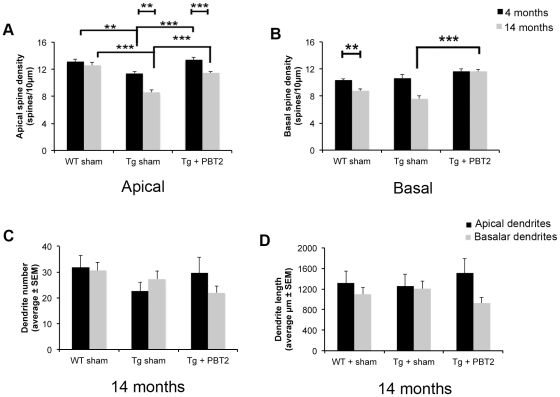
Dendritic spine analysis in Tg2576 mice and wildtype littermates.(A) Tg2576 animals have deficits in apical dendritic spine density at both four (n = 4) and fourteen (n = 5) months of age, as compared to WT mice (n = 4 at four months; n = 5 at fourteen months), that are reversed by short-term (11 days) PBT2-treatment (n = 3 at both age points). There are also age-related decreases in apical spine density in both the Tg groups. (B) There is a significant increase in basal spine density in fourteen month old Tg animals treated with PBT2. There is also an age-related decrease in basal spine density in WT animals. (C) There were no significant differences in apical or basal dendrite number across the experiment. (D) There were no significant differences in apical or basal dendrite length across the experiment. Values are mean ± SEM. **p<0.01, ***p<0.001.